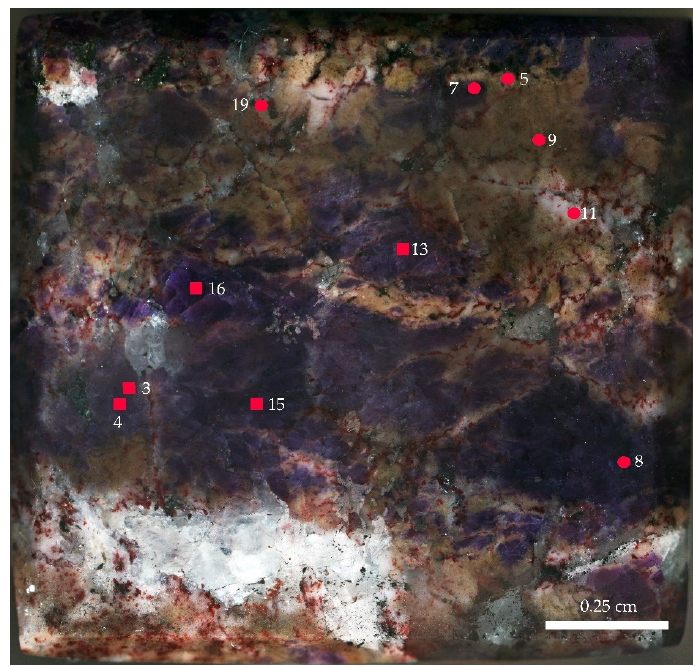
Figure 10. Analyzed points by Raman and FTIR spectroscopy. Circles identified diopside and squares omphacite. Table 4. Raman frequency (cm − 1 ) of our sample and literature data relative to diopside [35,37] ( a ) and omphacite [37,38] ( b ).